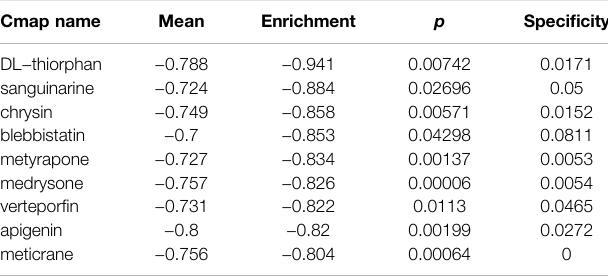
TABLE 1 | small molecular compounds having the potential to reverse the clinical manifestations in the high-risk